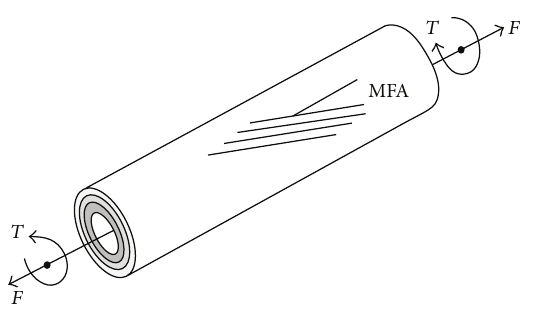
Figure 1: Idealized fiber geometry used in micromechanical mod- eling. MFA is the microfibril